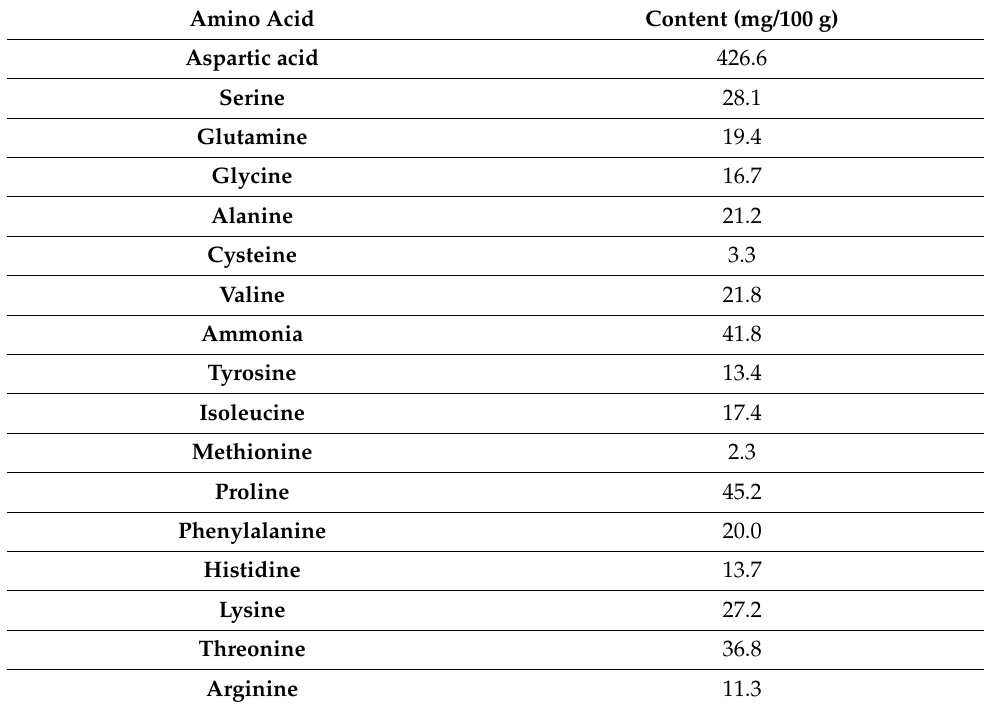
Table 1. Amino acids found in sea buckthorn according to